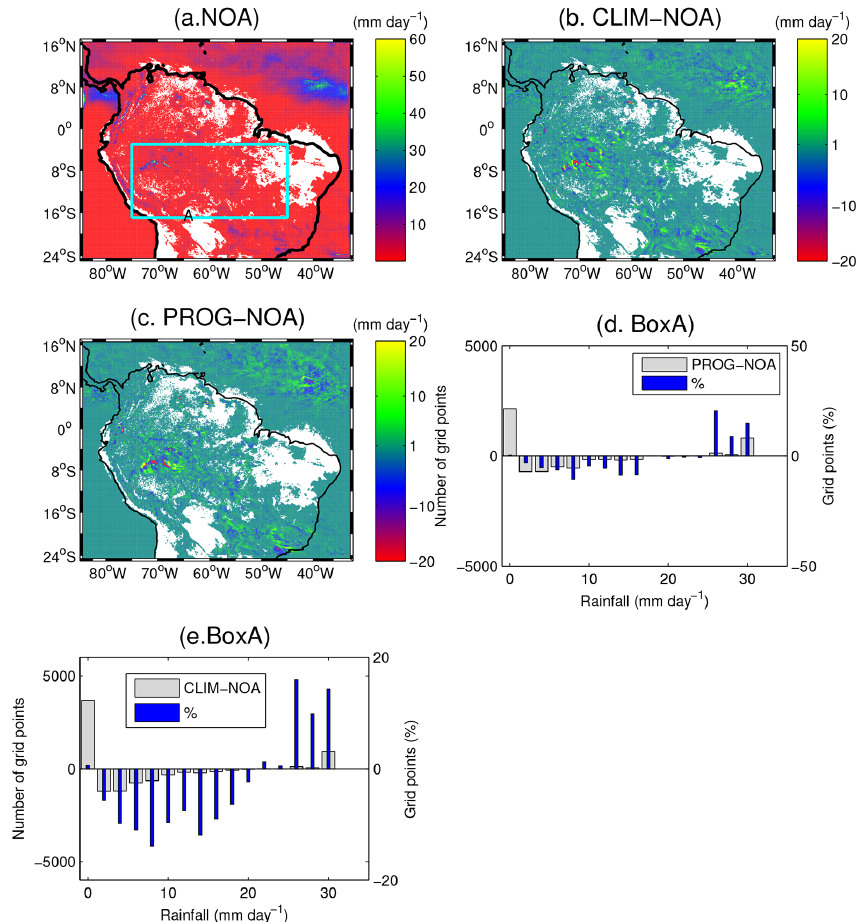
Figure 11. The whole SAMBBA period mean rainfall (a) and differences in rainfall (b, c) ; white region shows masked 0 values (a, b, c) and changes to frequency distributions of precipitation (d–e) from BBA to NOA for box A. Blue bars are in percentage with respect to